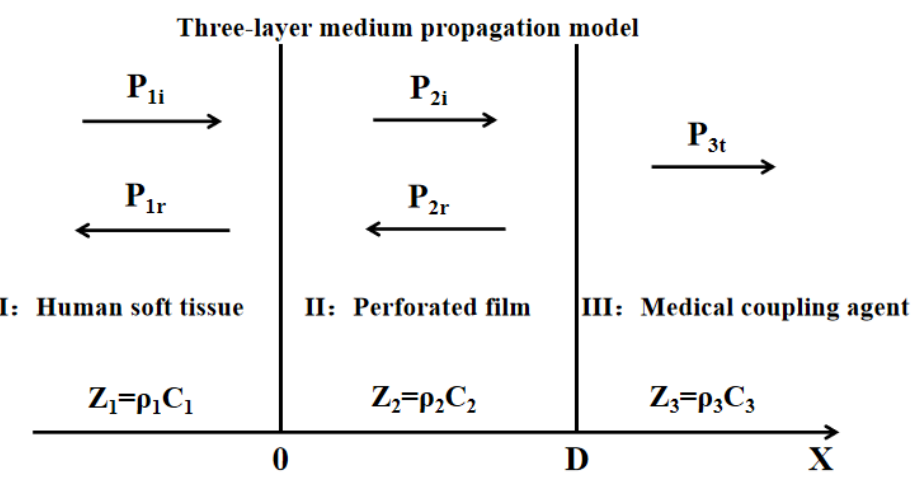
Figure 11. Three-layer medium propagation model.